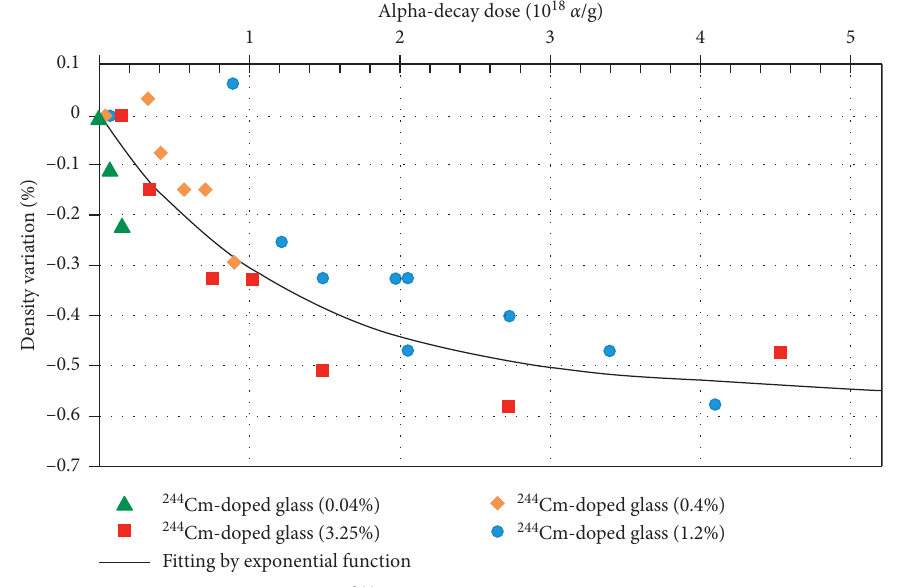
Figure 4: The effect of α -radiation caused by the decay of 244 Cm on density of borosilicate glass [4, 5]. Composition of the glass is given in Table 3. Table 3: Composition of borosilicate glasses produced by AREVA at La Hague (France).